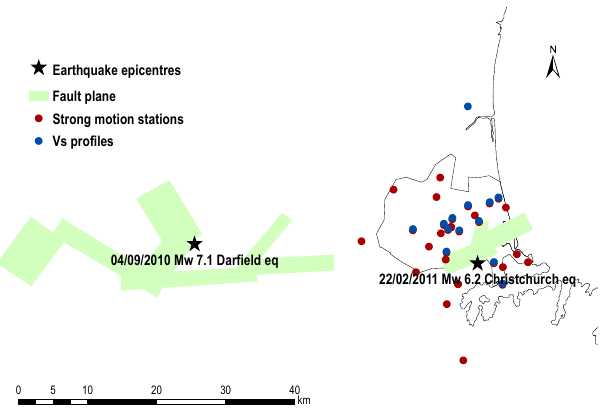
Figure 1. Locations of epicentres and fault planes (Beaven et al., 2012) of the Darfield and Christchurch earthquakes, strong-motion stations from which recordings are used to estimate shaking dura- tions and locations at which shear-wave velocity ( V S ) profiles are known (Wood et al., 2011). Note that locations of V S profiles coin- cide with strong-motion stations.